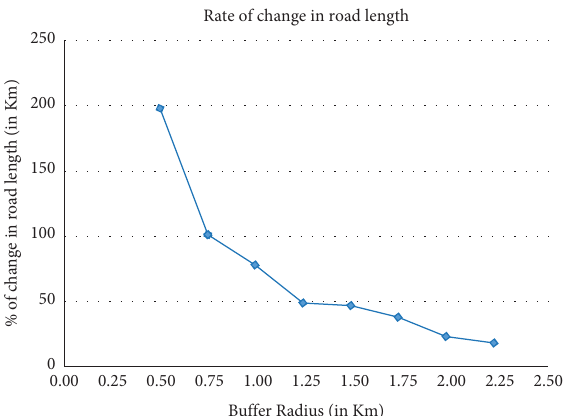
Figure 4: Rate of change in road length.